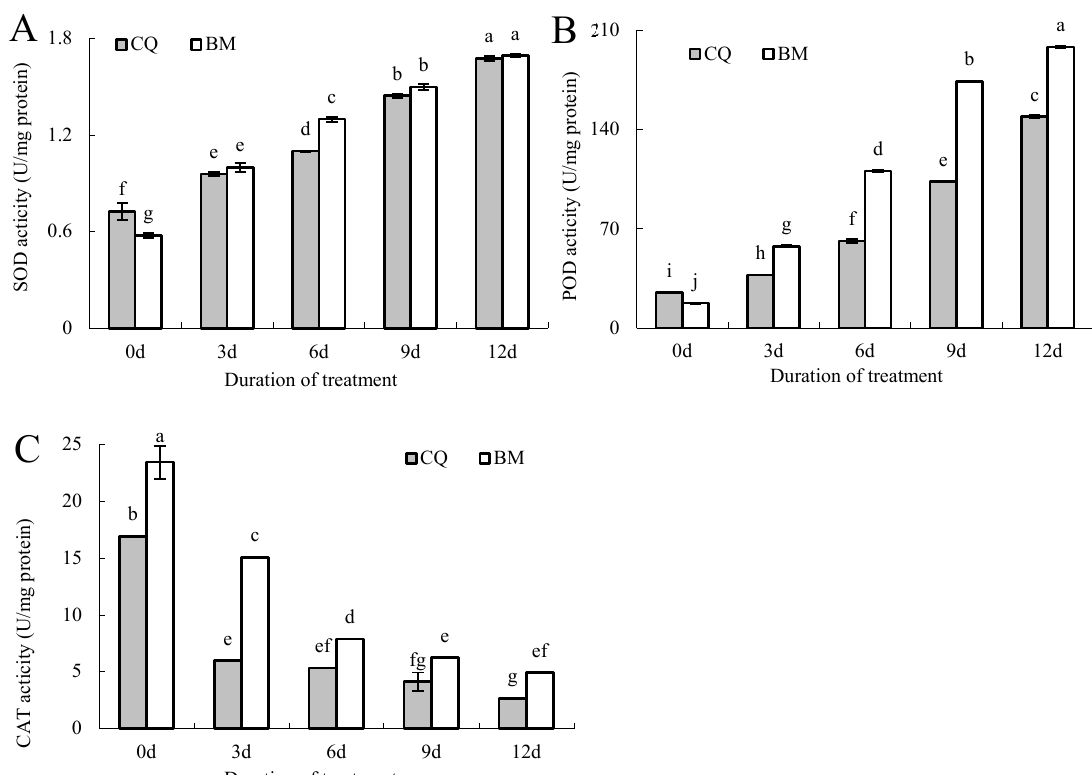
Figure 1. Determination of the activities of SOD ( A ), POD ( B ), and CAT ( C ) in the mitochondria of cucumber roots at 0, 3, 6, 9, and 12 days after Ca(NO 3 ) 2 treatment. Values are the means of three independent experiments. Bars marked with dissimilar letters are significantly different according to Duncan’s multiple range tests ( p < 0.05).